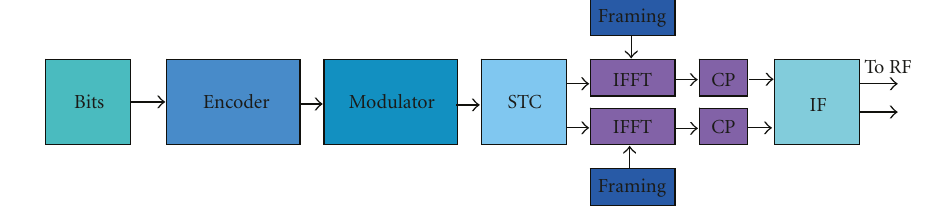
Figure 4: Base-Band and IF Transmitter Block diagram.